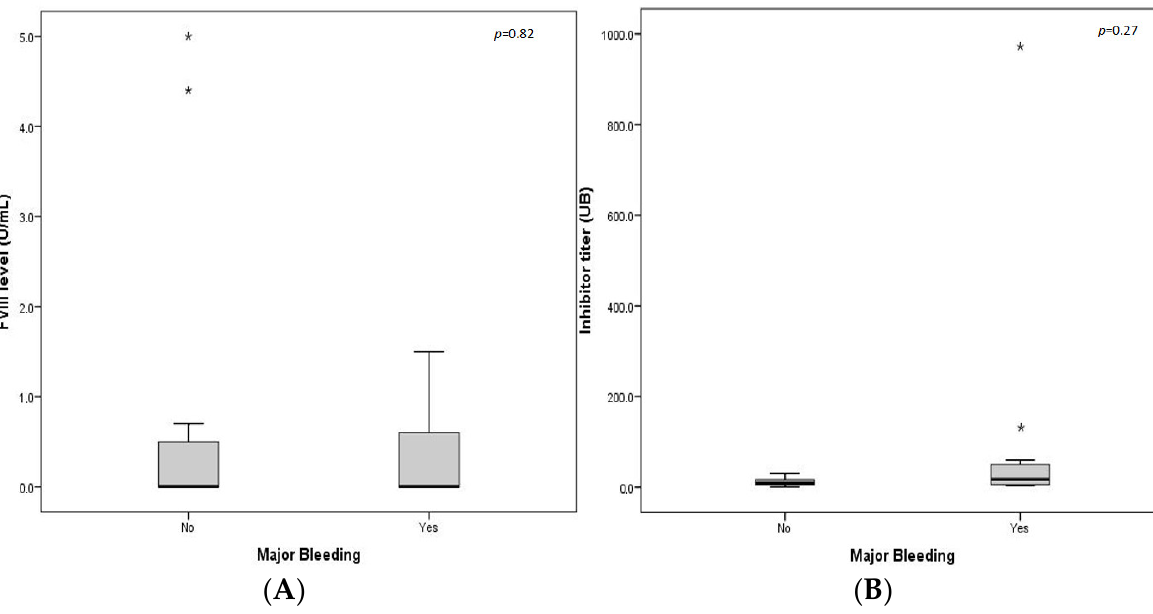
Figure 3. ( A ) Major bleeding episodes according to FVIII levels. ( B ) Major bleeding episodes according to inhibitor level. * Isolated case. Two independent samples from the non-parametric tests: U Mann–Whitney.